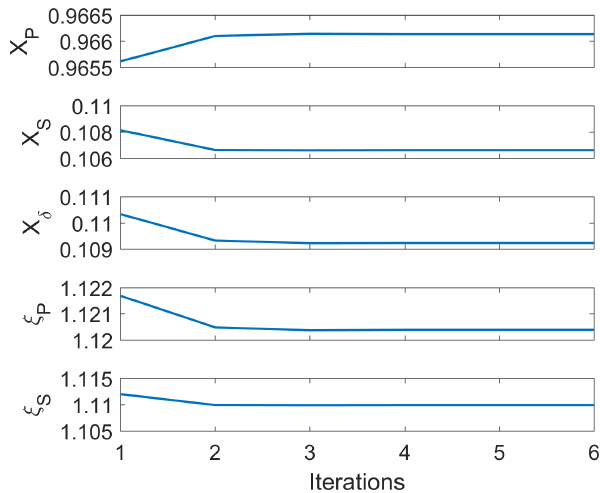
Figure A2. Instrumental channels obtained with an iterative proce- dure. We did not include the error bars since they are much larger than the variations among runs. Table A1. Results of the instrumental constants after using the iter- ative procedure (six